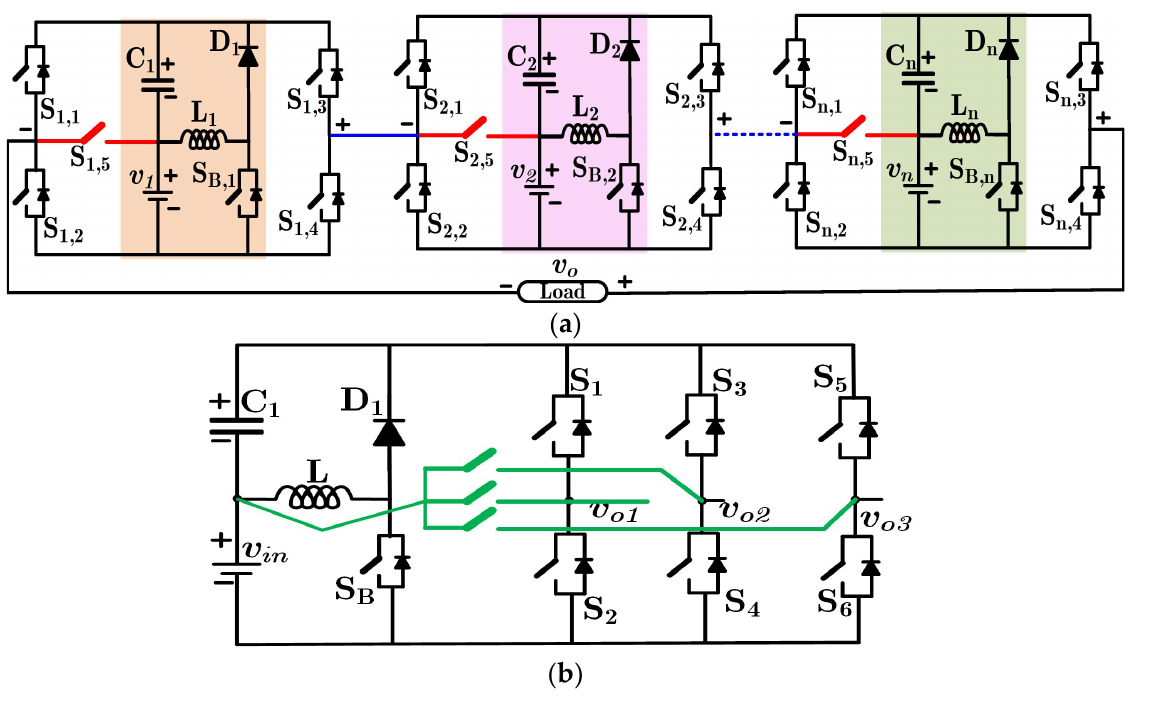
Figure 4. Extended Structures of proposed topology ( a ) cascaded extension and ( b ) 3 φ - extension. (L n —inductor, D n —diode C n —capacitor, v n —input voltage v o , n—output voltage, S n,1 -S n,5 , S n,B —switches, where n = 1,2,3 . . . ).